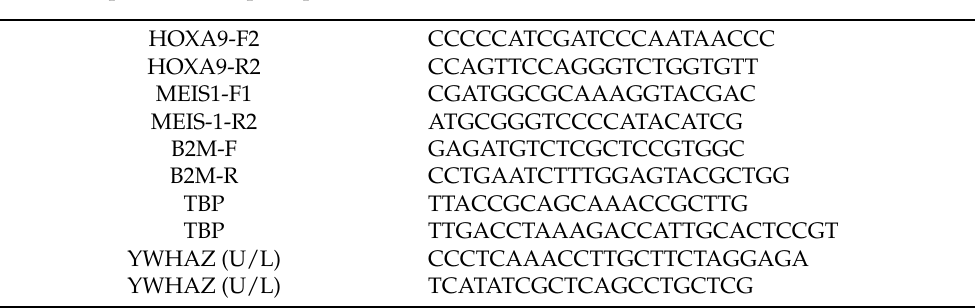
Table 2. Sequence of the qPCR primers.